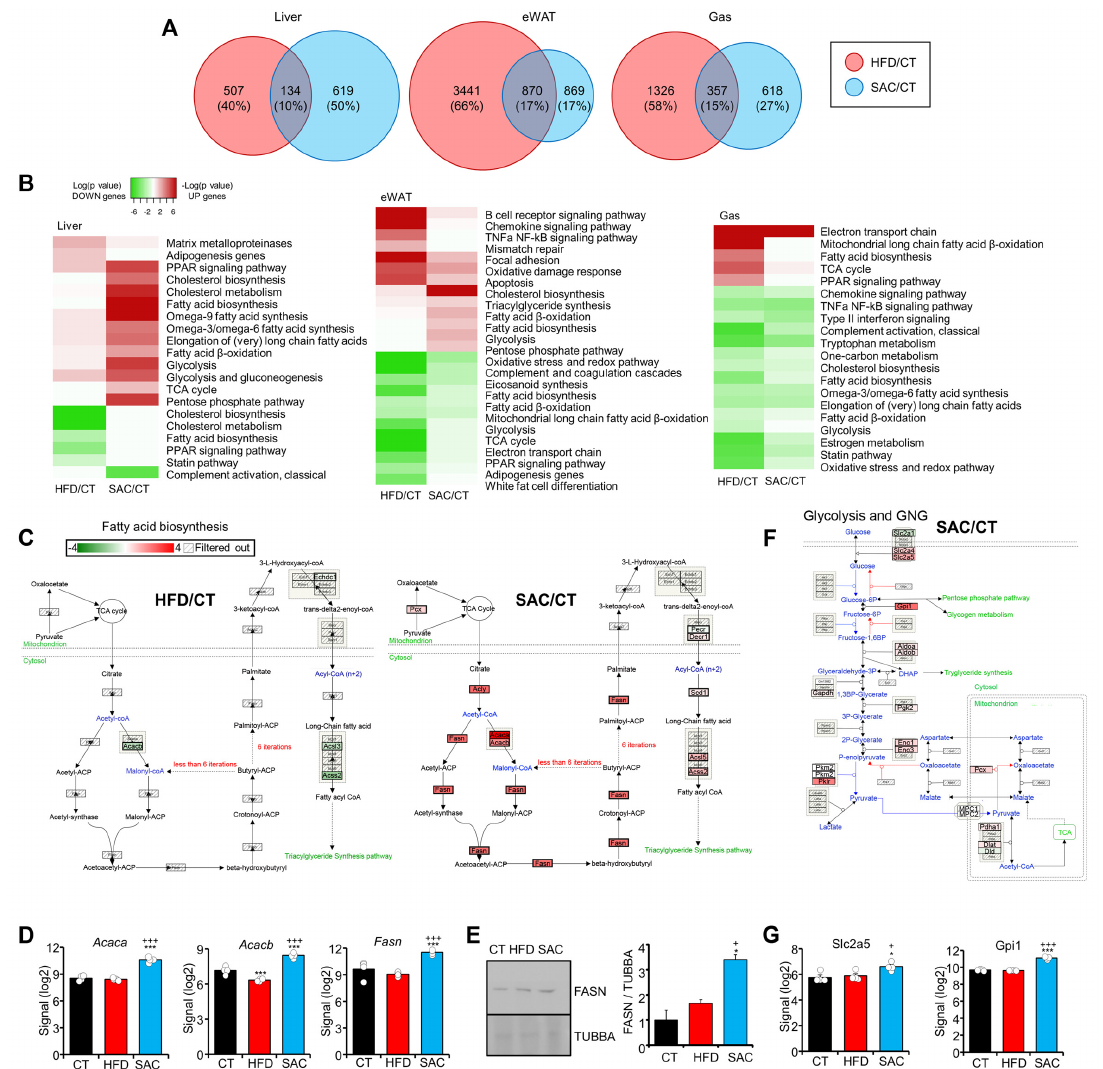
Figure 2. HFD and SAC induce distinct gene expression profiles in eWAT and liver. ( A ) Comparison of DEGs in HFD/CT and SAC/CT for each tissue analyzed using microarray hybridization. ( B ) En- richment analysis showing the log ( p value) of pathways associated with upregulated (red) or down- regulated genes (green) in the same tissues of HFD and SAC mice. ( C – E ): The fatty acid biosynthesis pathway is associated with downregulated genes in HFD mice and with upregulated genes in SAC mice ( C ), including FASN, as determined by mRNA ( D ) and protein levels ( E ). ( F , G ): The glycolysis and gluconeogenesis (GNG) pathway is associated with upregulated genes only in SAC mice ( F ) including fructose handling genes such as Slc2a5 ( G ). n = 4/group ( A – D , G ) and n = 3/group ( E ). * p < 0.05, and *** p < 0.005 with respect to the CT group. + p < 0.05, and +++ p < 0.005 with respect to the HFD group. Gas = gastrocnemius. Pathway analysis of the DEGs highlights the enrichment of lipid metabolic pathways among the upregulated genes in the liver of SAC mice (Figure 2B, Supplementary Table S1). Fatty acid biosynthesis, including the key enzymes Acaca , Acacb , and Fasn , was re- markably increased (Figure 2C–E, Supplementary Figure S2D), as was cholesterol biosyn- thesis (Supplementary Figure S2E,F). Interestingly, both pathways were downregulated